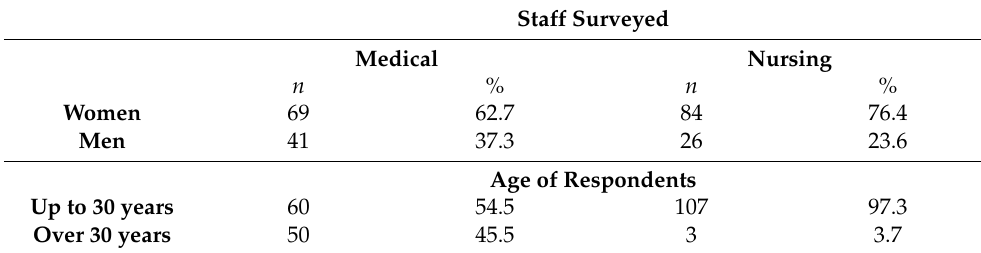
Table 1. Respondents by demographic characteristics. Staff Surveyed Medical Nursing n % n